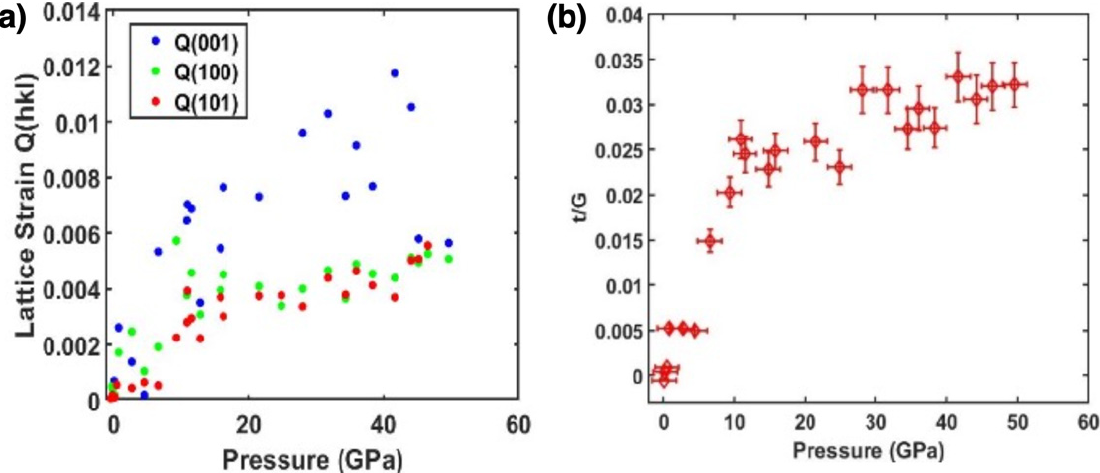
Figure 7. ( a ) Orientation dependent lattice strain Q(hkl) in HfB 2 to 50 GPa. ( b ) The differential stress normalized to shear modulus ( t /G ratio) for HfB 2 as a function of pressure to 50 GPa. The lattice strains Q(hkl) for (001), (101), and (002) planes given by Equation (2) for